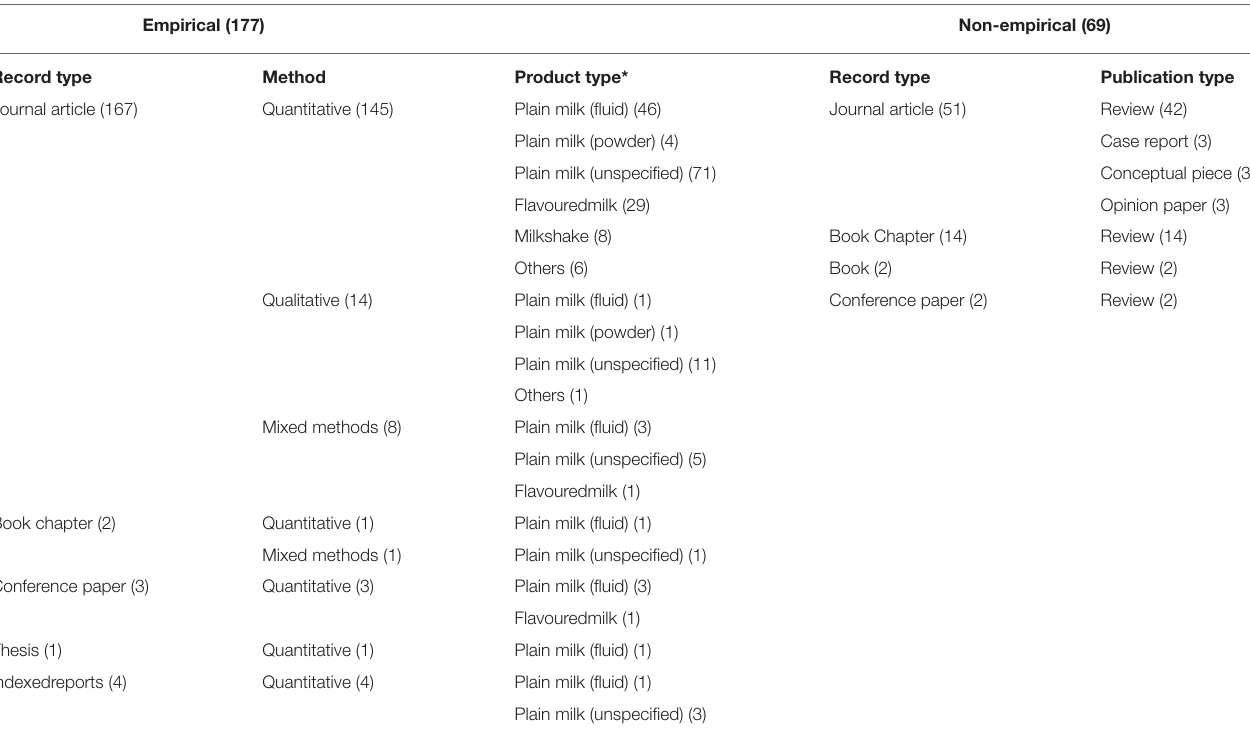
TABLE 1 | A summary of empirical and non-empirical records by record type, method, product type, and publication